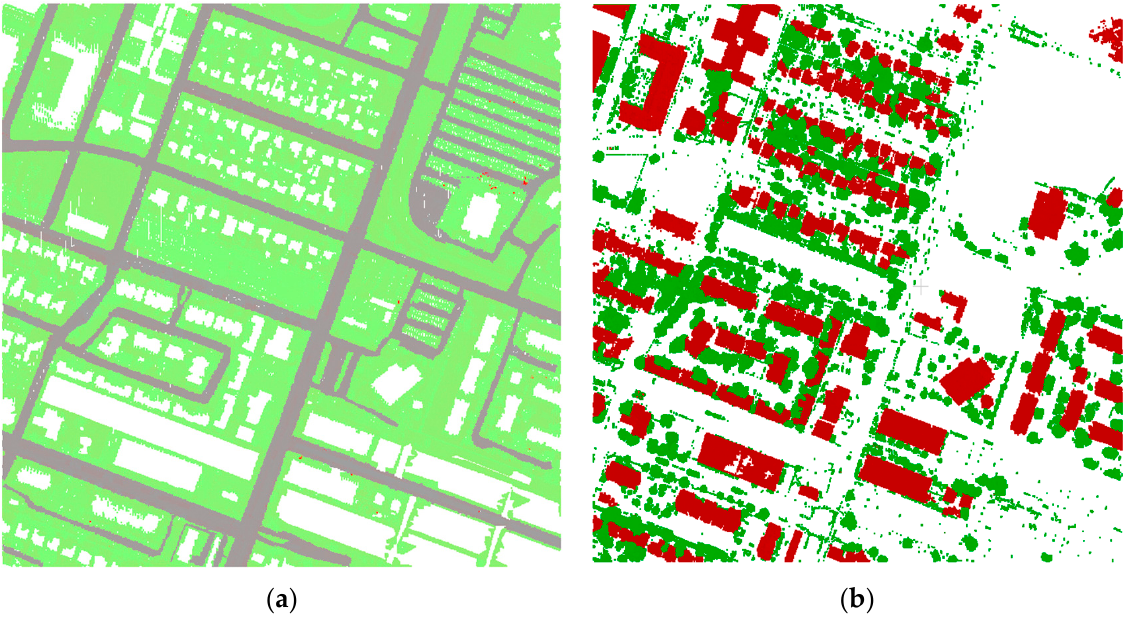
Figure 4. Point cloud filtering in the study area. ( a ) ground points; ( b ) non-ground points.